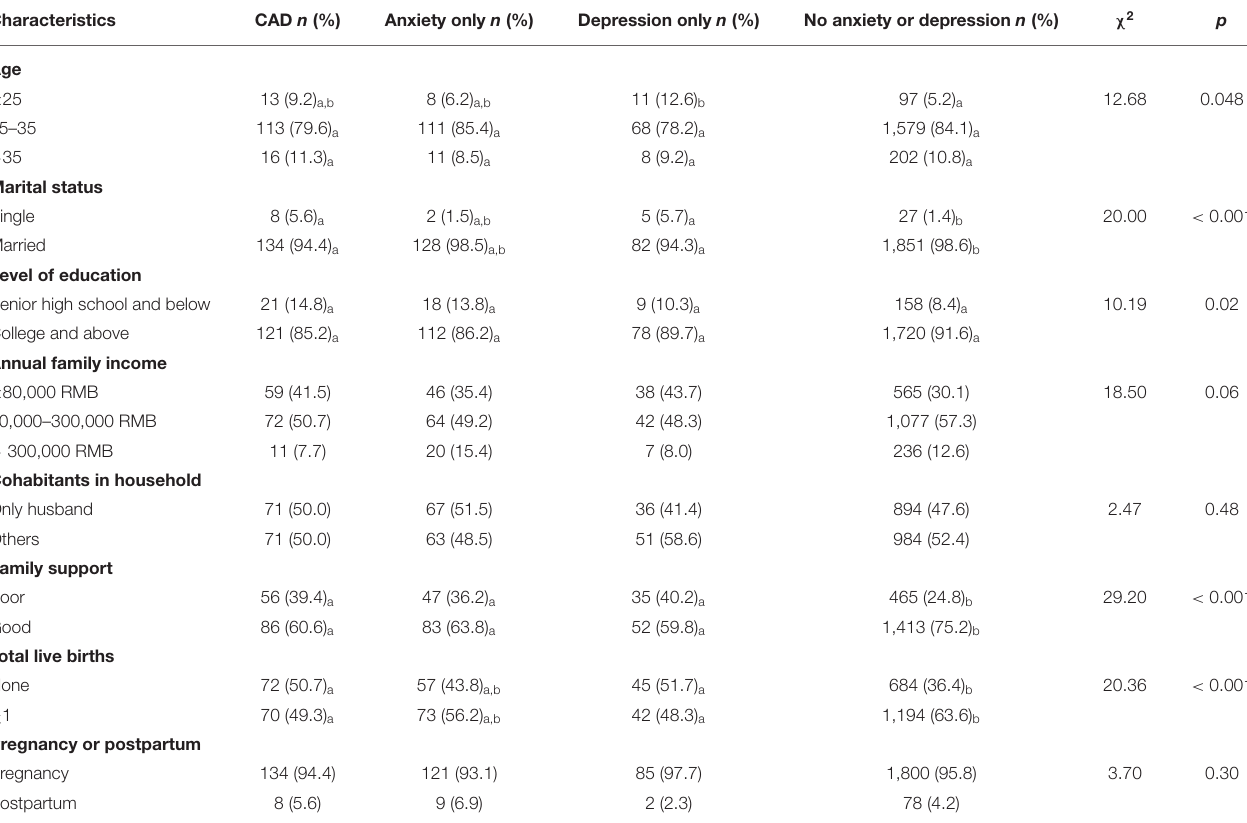
TABLE 2 | Sociodemographic and obstetric characteristics of participants in comorbid anxiety and depression (CAD), “anxiety only,” “depression only,” and “no anxiety or depression” groups.